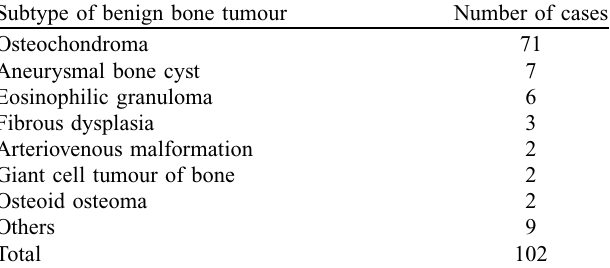
Table 3. Commonest benign bone tumours of the scapula.